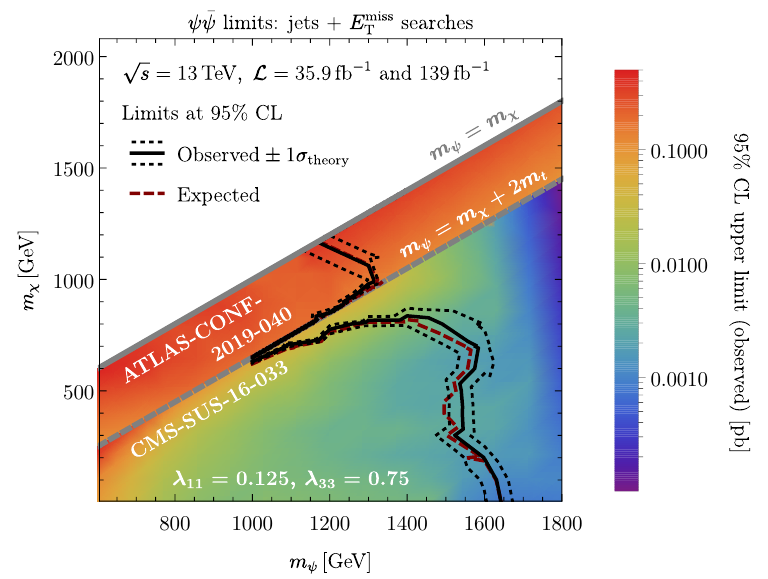
Figure 7 . Limits on sextet fermion pair production from ATLAS-CONF-2019-040, a search at √ s = 13 TeV ( 139 fb − 1 ) for gluinos in final states with jets and missing transverse momentum; and from CMS-SUS-16-033, a similar search ( 35.9 fb − 1 ) for supersymmetry in multijet events with missing as seen from top quarks. Cross sections are computed for m ϕ = 1.15 TeV, λ 11 = 0.125 , λ 33 = 0.75